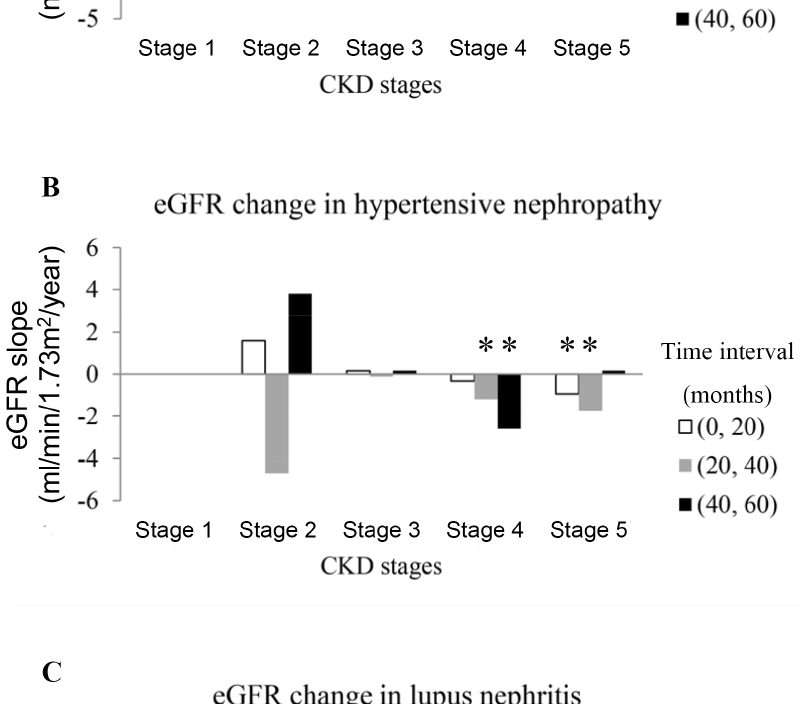
Figure 2B). Lupus nephritis was not significantly associated with eGFR decline, except in CKD stage 4, with 2 3.384 mL/min/